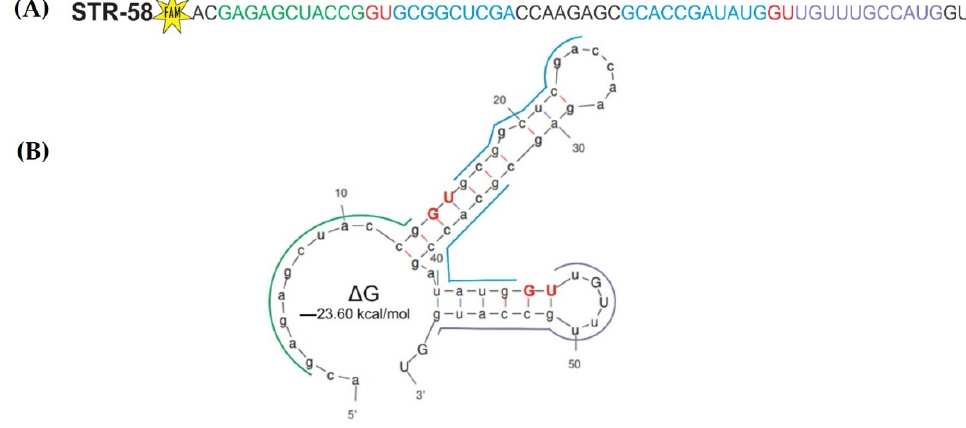
Figure 2. The structure of STR-58 fragments. ( A ) The sequence of RNA STR-58 with FAM-label on the 5′-end. STR-58 fragment was used as the substrate. Red letters indicate cleavage site for cleavage agents (GU). Green, blue, and purple lines are the binding sites for cleavage agent hybridization. ( B ) Stable secondary structure of STR-58 that mimics biological RNA. ∆ G is − 23.6 kcal/mol. The secondary structure was achieved by using the mFold web server (The RNA Institute-University at Albany). The website of mFold Web Server is http://unafold.rna.albany.edu/, accessed on 10 October Table 1. Oligonucleotides used in the experiment .